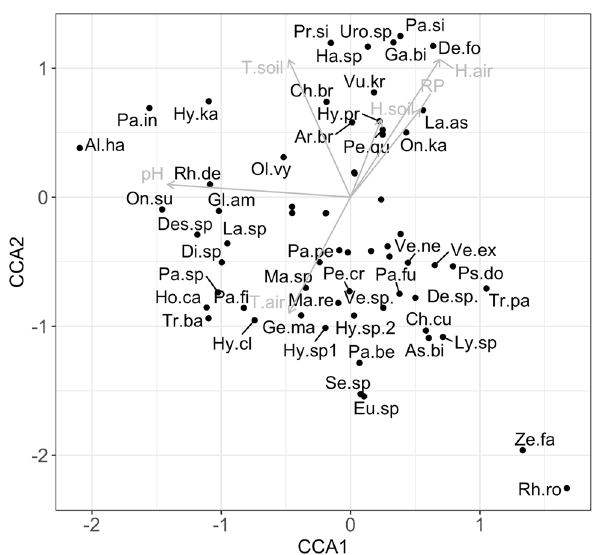
Figure 3. Biplots of the canonical correspondence analysis model of species abundance matrix in relation environmental variables. Length and direction of arrows indicate the relative importance and direction of change in the environmental variables. Variables are: T-soil and T-air, H-soil and H-air, pH, RP. Species names were abbreviated using the initials of the genus and species name (abbreviations are reported in Tables 3 and